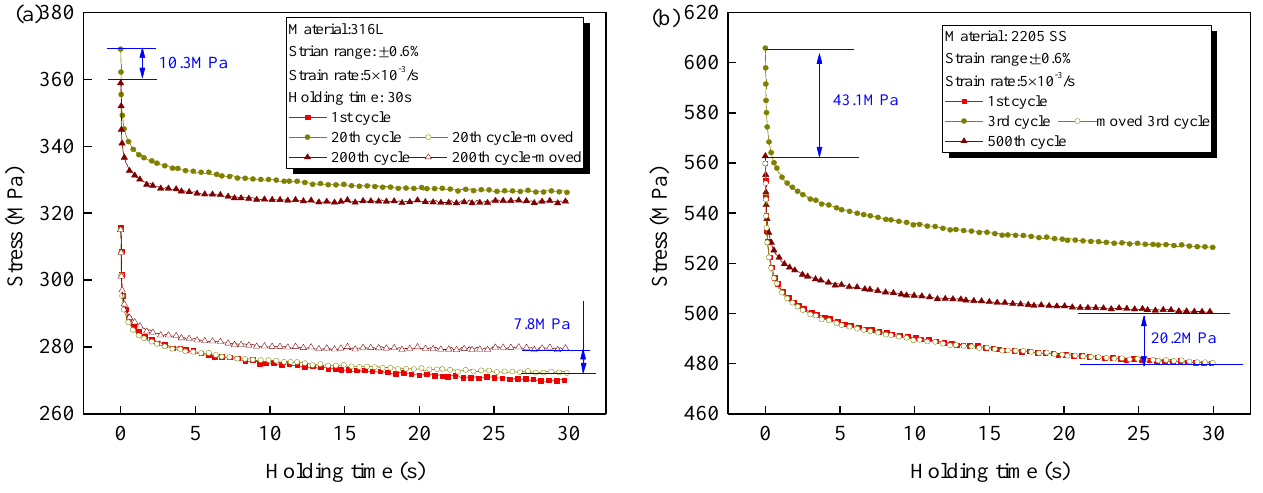
Figure 8. Evolution of stress relaxation behaviour for ( a ) 316L and ( b ) 2205.